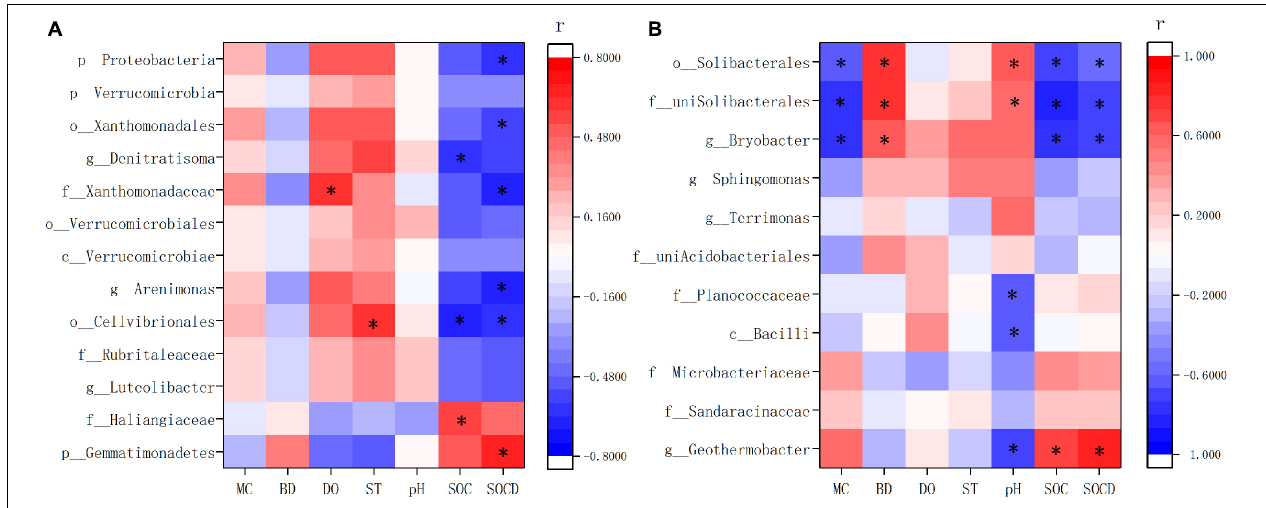
FIGURE 8 | Correlation matrix based on Spearman correlation analysis between soil properties and indicator species in Xinxue River (A) and Xinxue River Constructed Wetland (B) . MC, Moisture content; BD, bulk density; DO, dissolved oxygen; ST, soil temperature; SOC, soil organic carbon content; SOCD, soil organic carbon density. The different taxonomy units are represented by: p, phyla; c, class; o, order; f, family; g, genus. * p <